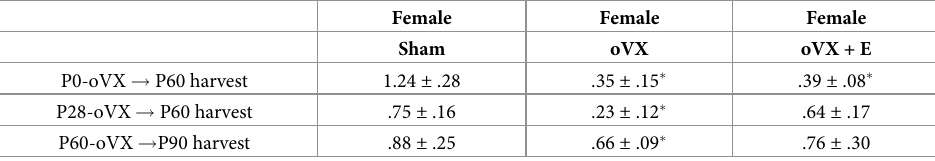
Table 2. Uterine horn weight (experiment